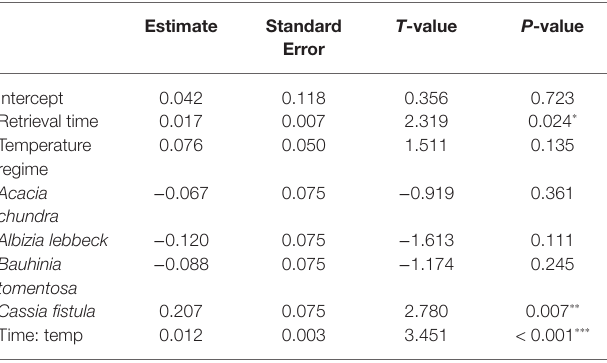
TABLE 2 | Results of overall general linear model (GLM) on the effects of retrieval time (months), temperature regime (control, +2 ° C, and + 4 ° C), species, and the interactive effect of retrieval time and temperature regime (Time: temp) on germination